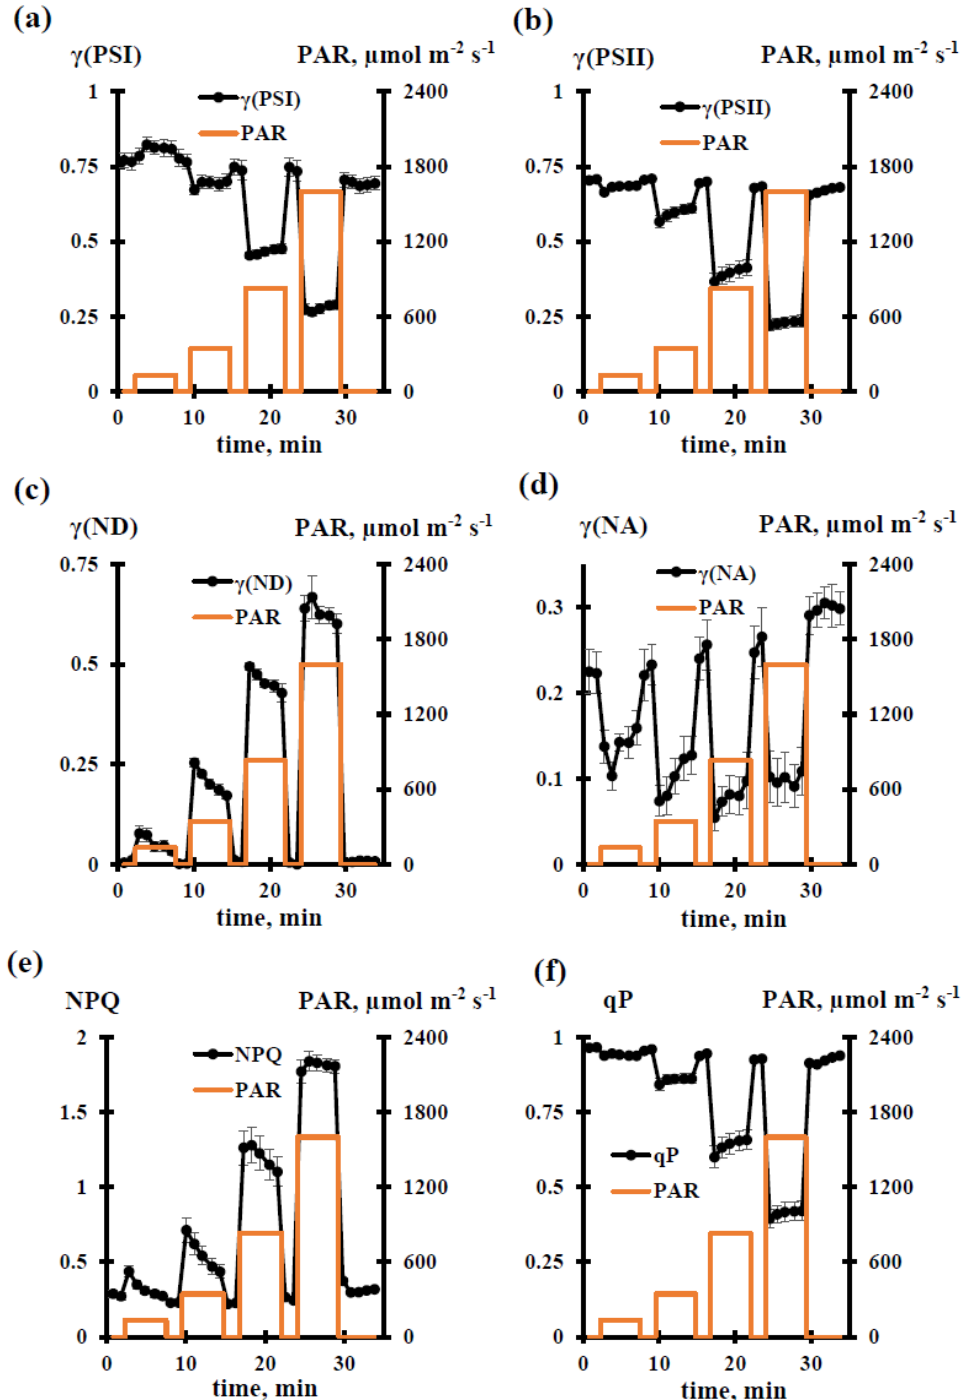
Figure 2. Averaged light curves for the parameters of the light reactions in photosystems I and II (PSI and PSII, respectively) in pea leaves ( n = 6). ( a ) the quantum yield of PSI ( γ (PSI)); ( b ) the quantum yield of PSII ( γ (PSII)); ( c ) the fraction of overall P700 that is oxidized in a given state ( γ (ND)); ( d ) the fraction of overall P700 that cannot be oxidized by the saturation pulse in a given state due to a lack of acceptors ( γ (NA)); ( e ) the non-photochemical quenching (NPQ); ( f ) the photochemical quenching (qP). PAR was the intensity of the actinic light. The photosynthetic parameters were measured every minute (every saturation